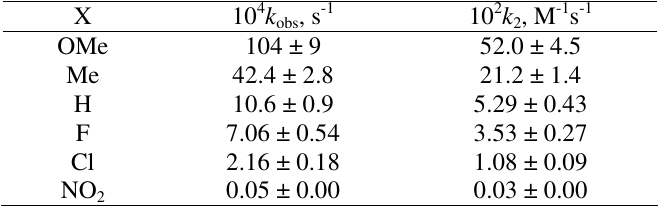
Table 4. Pseudo-first-order and second-order rate constants for the oxidation of